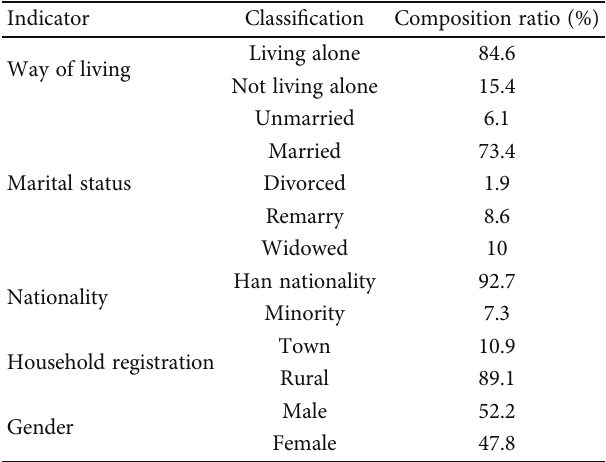
Figure 3: Activities of daily living (ADL) of the elderly in the